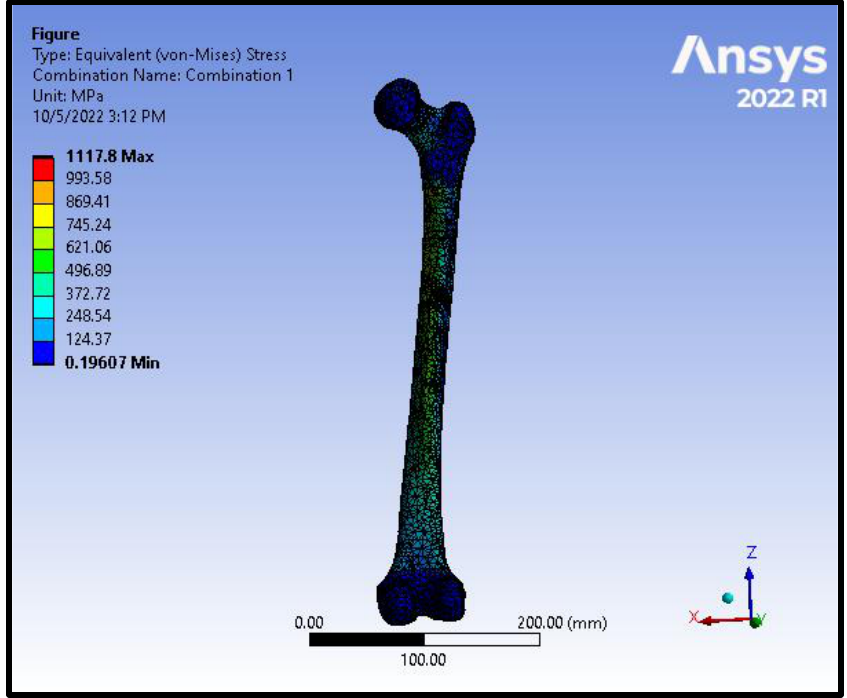
Figure 7. von Mises stress distribution on the femoral model in an intracapsular fracture under axial compression and torsion scenario.